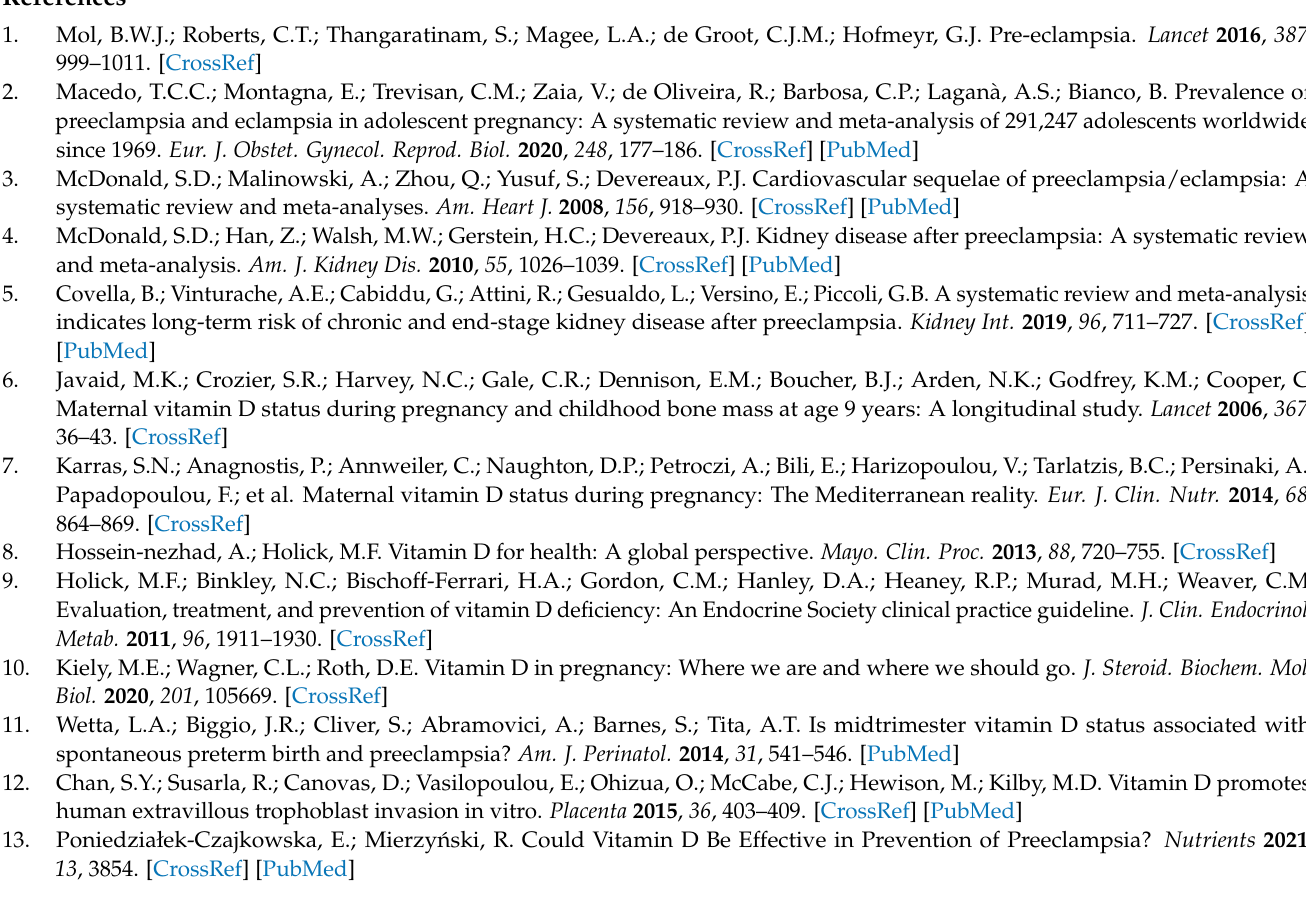
Funnel plot to assess publication bias. (a): Studies evaluating replete versus insufficient or deficient vitamin D levels; (b): Studies evaluating replete or insufficient versus deficient vitamin D levels; (c): Studies evaluating replete versus insufficient vitamin D levels; (d): Studies evaluating replete versus deficient vitamin D levels; Figure S3: Sensitivity analysis investigating the influence of a single study on the overall meta-analysis estimate. (a): Studies evaluating replete versus insufficient or deficient vitamin D levels; (b): Studies evaluating replete or insufficient versus deficient vitamin D levels; (c): Studies evaluating replete versus insufficient vitamin D levels; (d): Studies evaluating replete versus deficient vitamin D